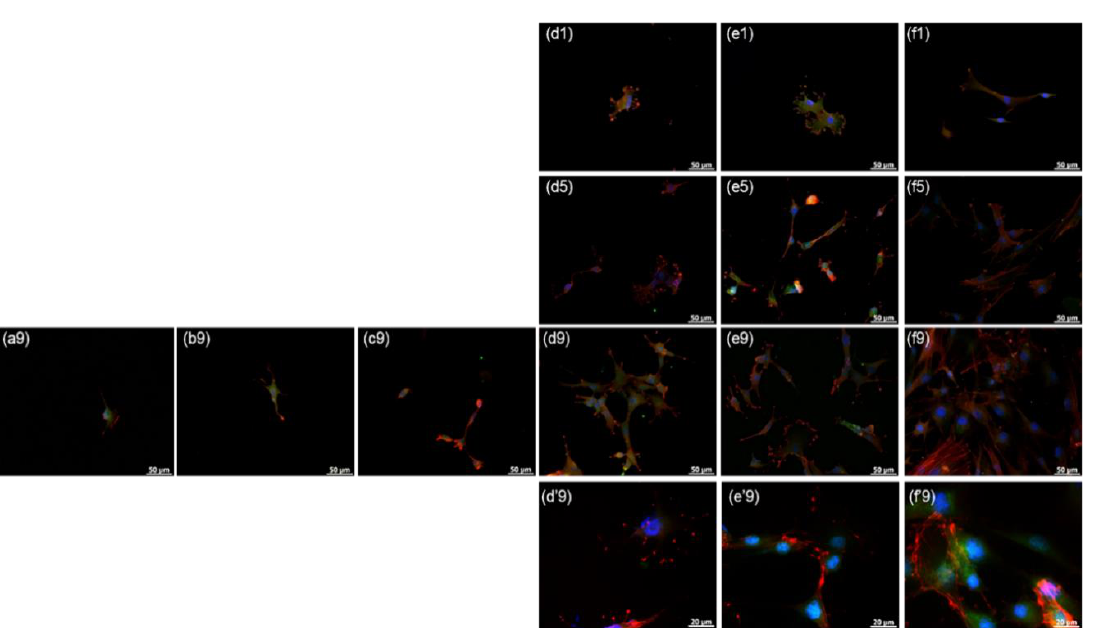
Figure 5. Actin–focal adhesion immunostaining in rMDSCs grown on SN for 1, 5, and 9 days. ( a ) SN-60, ( b ) SN-150, ( c ) SN-300, ( d ) SN-500, ( e ) SN-700, and ( f ) glass. The numbers indicate 1, 5, and 9 days. Diamino-2-phenylindoadihydrochloride (DAPI) (blue), actin (red); focal adhesion (vinculin; green). Magnification, ×400; scale bar = 50 μm. ( d’9 ), ( e’9 ), and ( f’9 ) are enlarged images (magnification, ×1000). (The enlarged actin–focal adhesion immunostaining images are shown in Supporting Information Figures S2 and S3).